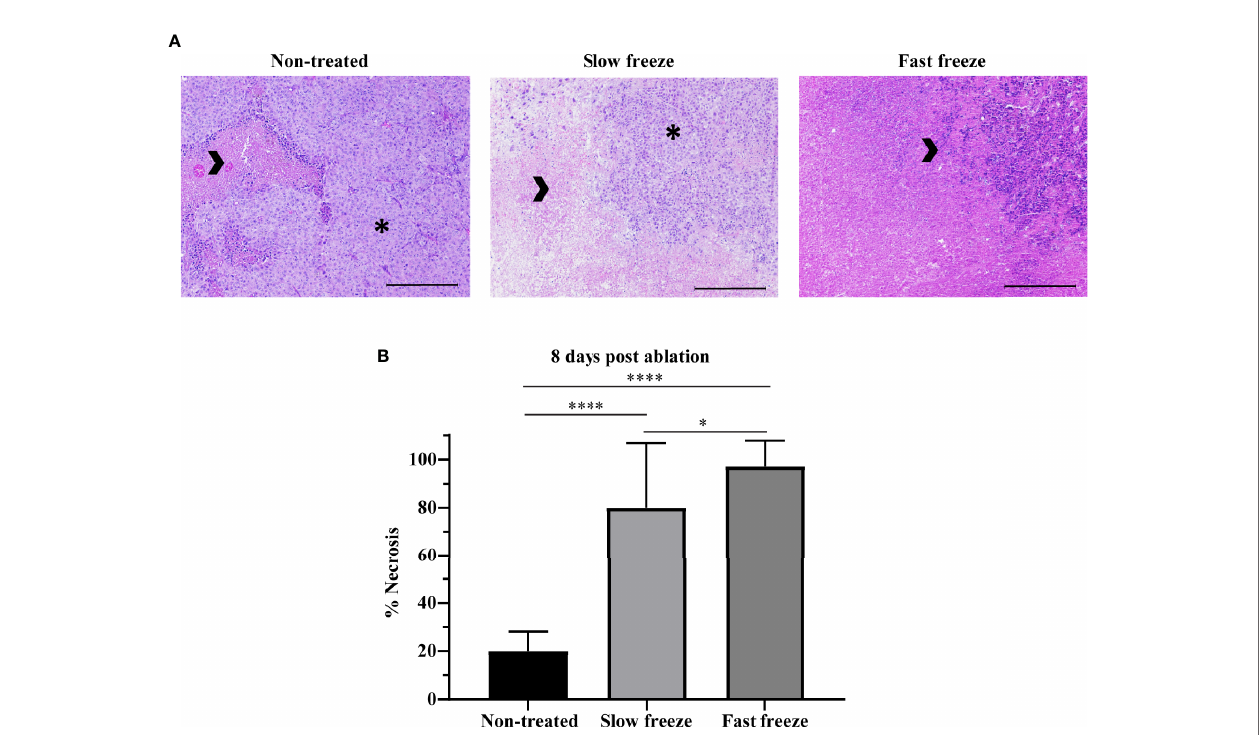
FIGURE 2 | Impact of differential freeze rate on tumor necrosis. (A) Representative images of H&E staining of tumor tissue sections obtained at 8 days post cryoablation, along with non-treated tumor controls. Images acquired at 10X magni fi cation. Arrowheads indicate necrotic tissue, and asterisks indicate viable tumor. Scale represents 1000µm. (B) Quanti fi cation of tumor necrosis in non-treated and cryoablated tumor tissues. Data plotted as mean and ± S.D. obtained from two independent experiments (n = 7-14). Data was analyzed using non-parametric Mann-Whitney U test. * P < 0.05, **** P <